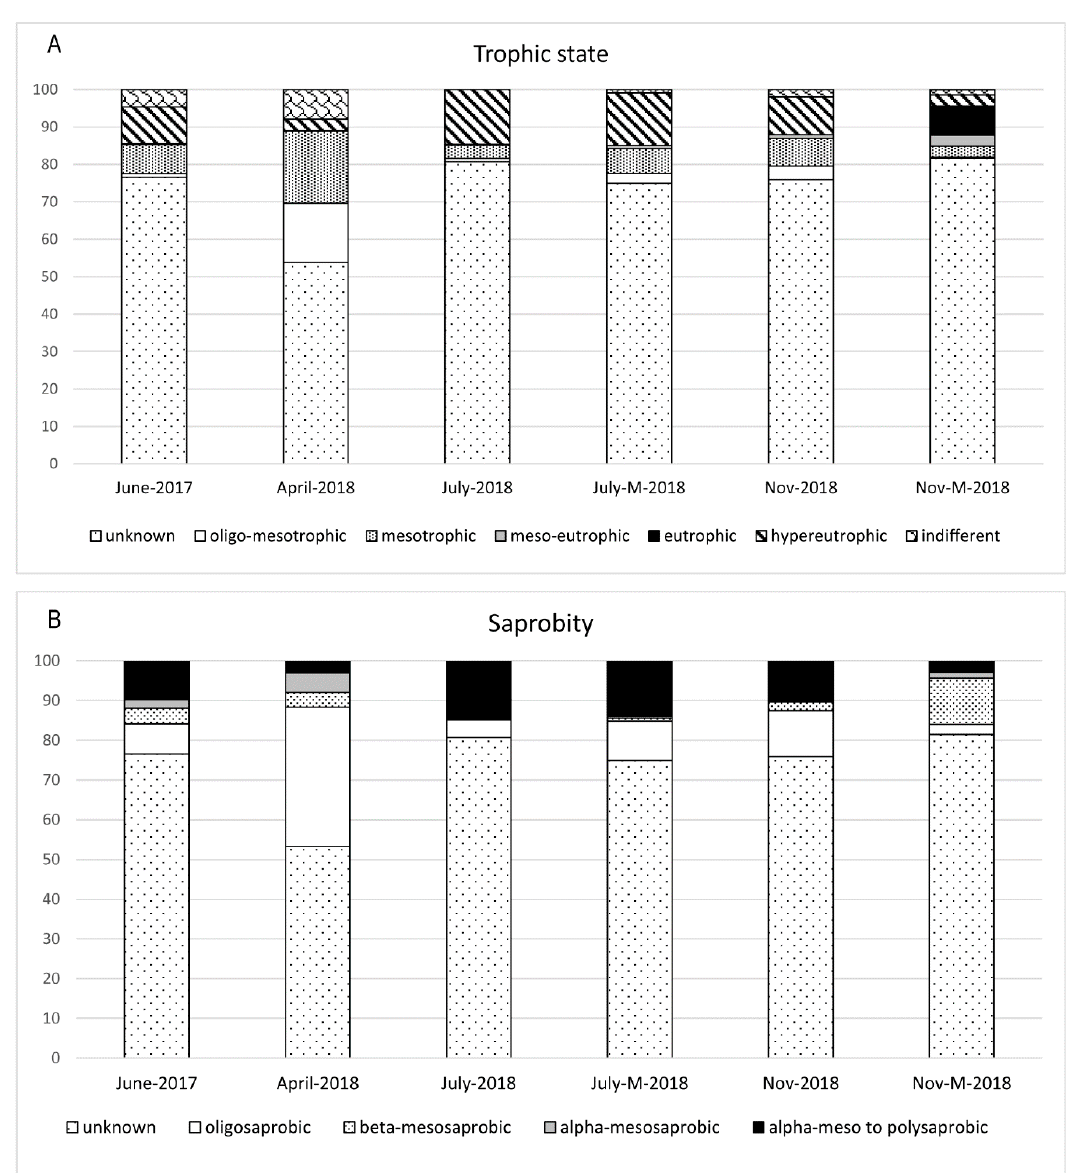
Figure 8. Ecological traits retained: trophic state ( A ) and saprobity ( B ) obtained in 2017 and 2018 (M = macrophytes).